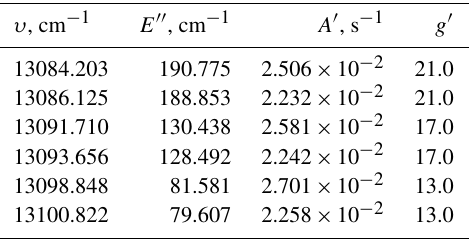
Table 1. Constants for O 2 A-band rotational structure calculation (Rothman et al.,